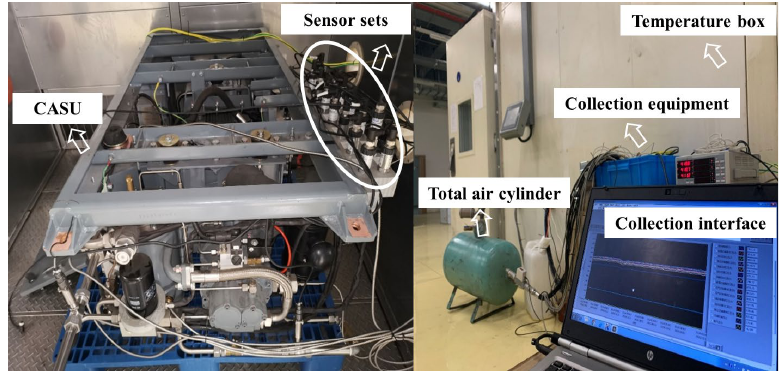
Figure 4. Performance degradation test rig of compressed air supply unit.